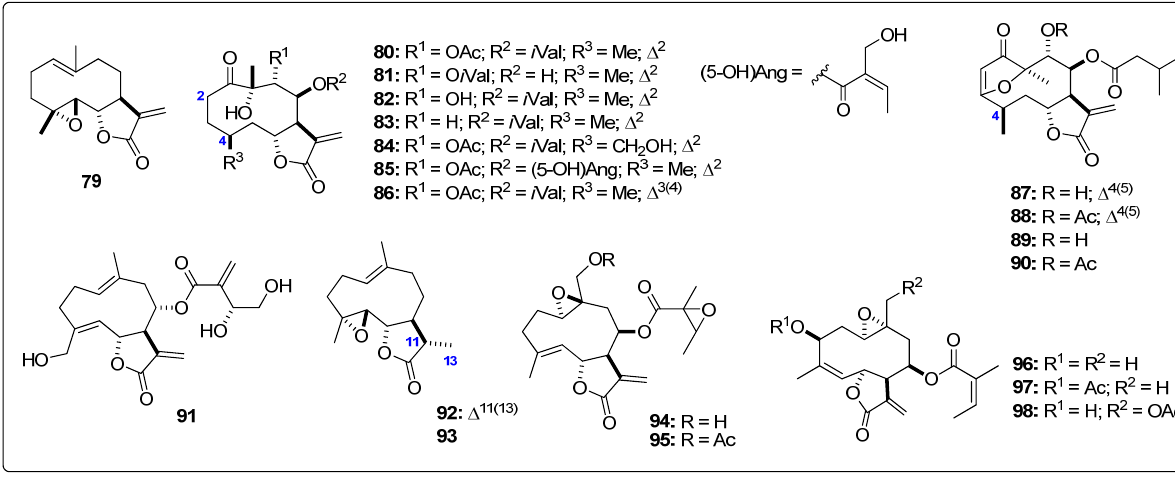
Figure 7. Structures of the tested germacranolide sesquiterpenes [27,30–32].